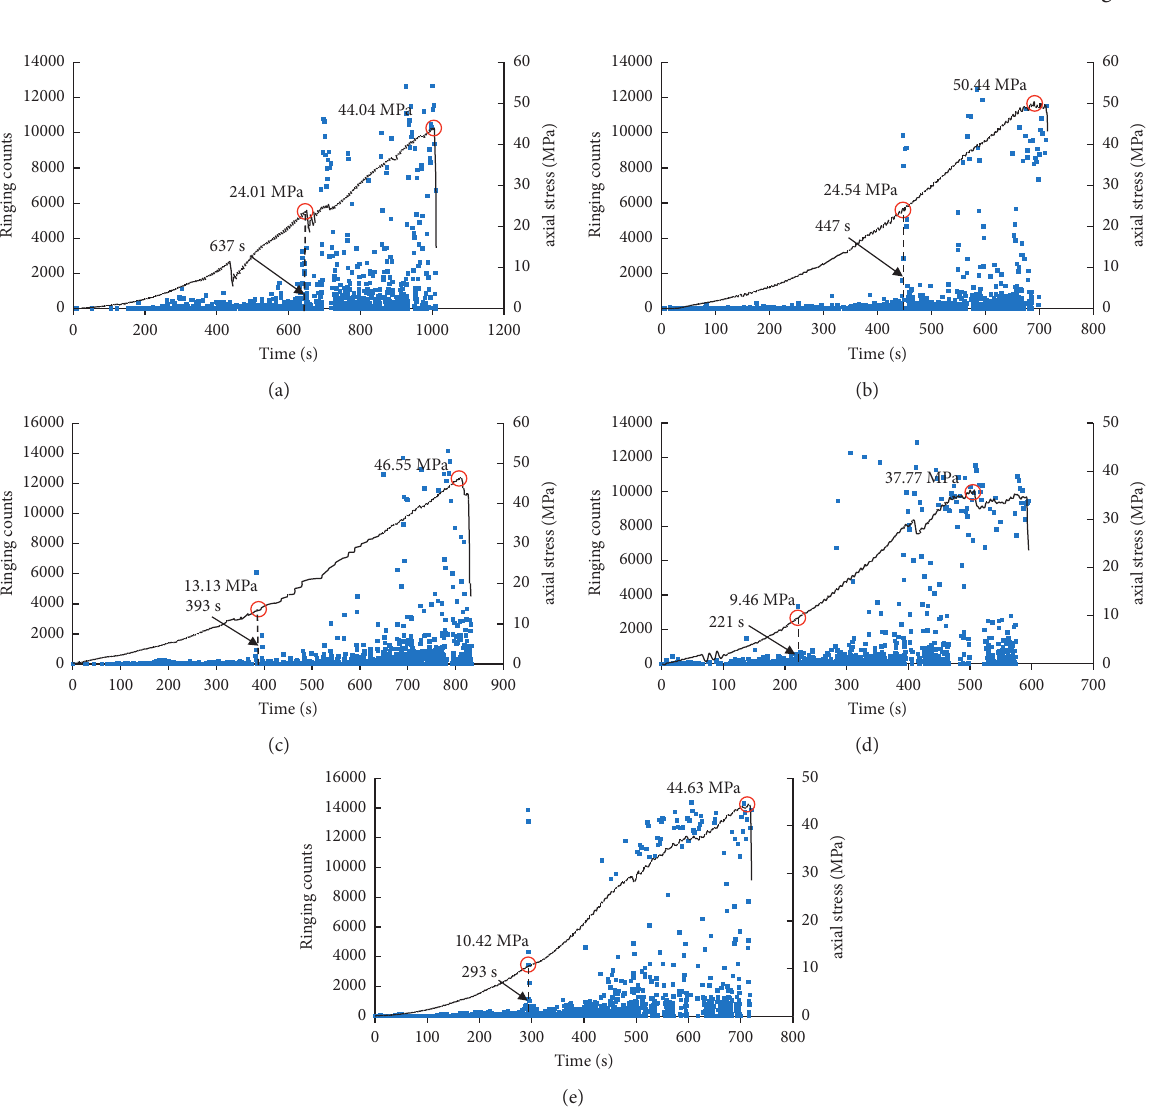
Figure 4: Acoustic emission ringing count-time-axial stress diagram: (a) α � 45 ° , β � 0 ° ; (b) α � 45 ° , β � 30 ° ; (c) α � 45 ° , β � 45 ° ; (d) α � 45 ° , β � 60 ° ; (e) α � 45 ° , β � 90 °